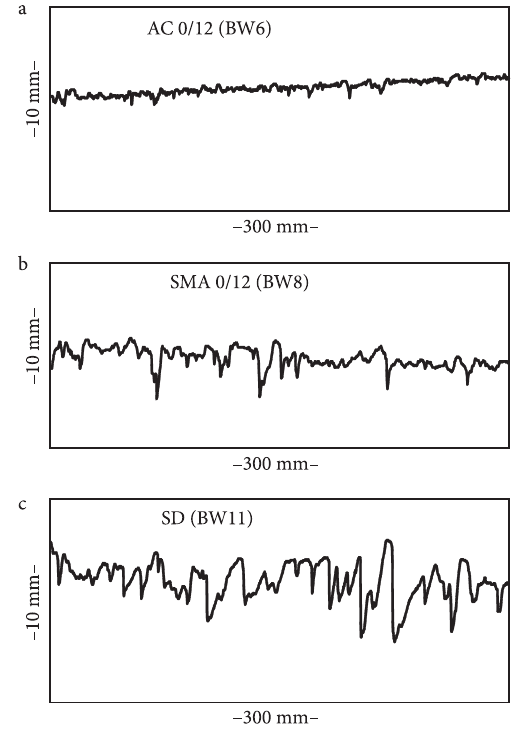
Fig. 2. Profiles of irregularities of pavements on tested sections: a – asphalt concrete: MPD = 0.35 mm; b – stone mastic asphalt (SMA):